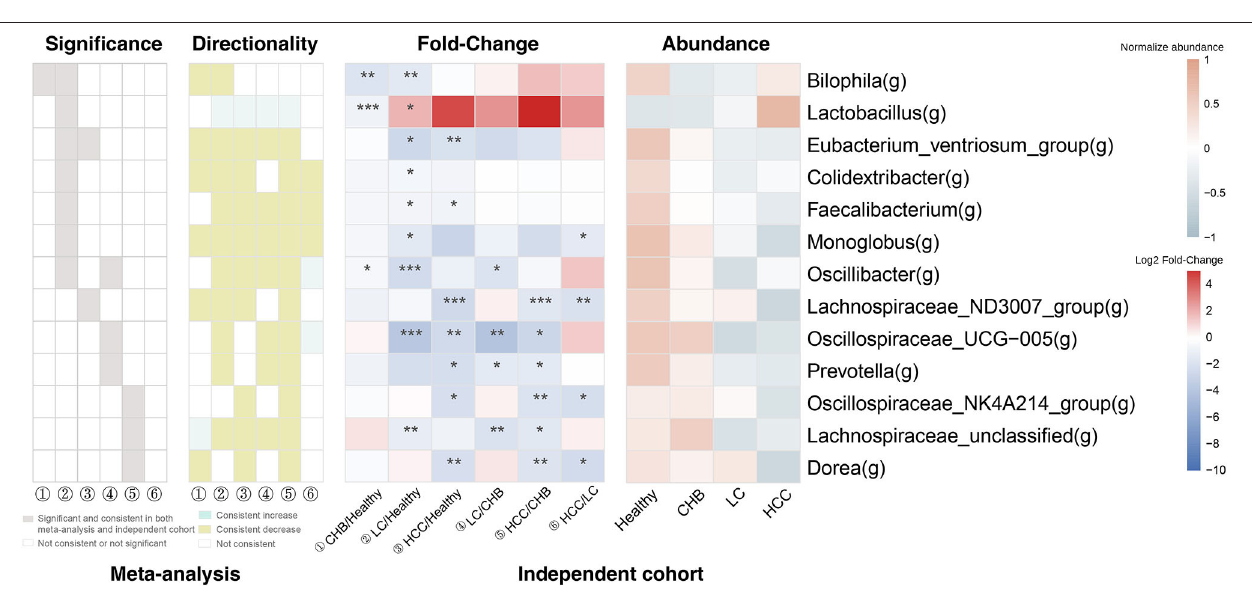
FIGURE 4 | The consistency of the 13 signature genera between public and validation datasets. For each genus, the gray box indicates the pair wise comparison that the genus was both significantly and consistently altered in public and validation datasets. The green and yellow box indicates the pair wise comparisons that the genus was consistently increased or decreased in public and validation datasets (but not necessarily significant). The 2 heat maps indicate the fold-change across the pair wise comparisons and the average relative abundance across the four subgroups in the validation dataset. ‹ CHB vs. Healthy; › LC vs. Healthy; fi HCC vs. Healthy; fl LC vs CHB; (cid:176) HCC vs. CHB; – HCC vs. LC. * p < 0.05; ** p < 0.01; *** p <